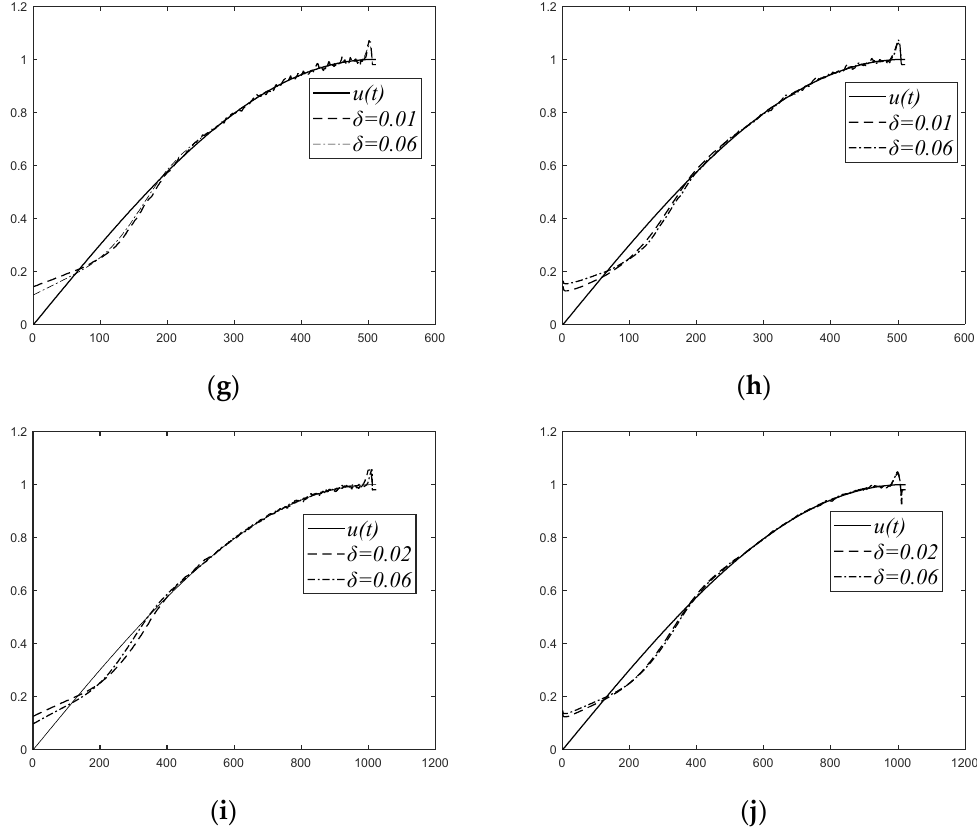
Ω = 64, ( b ) algorithm 3 V.M in